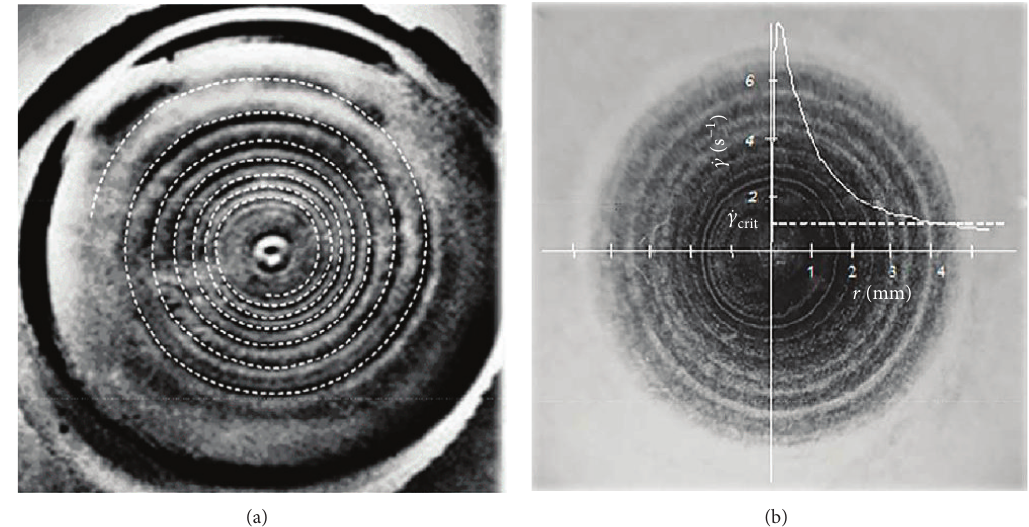
Figure10:Experimentalexamplesofthering-likemorphologyformationinpolycarbonatemeltafterdismountingofthecone-plateoperating unit (a) and in poly(isobutylene) slightly filled with Na-montmorillonite particles between transparent sphere and plate (b).